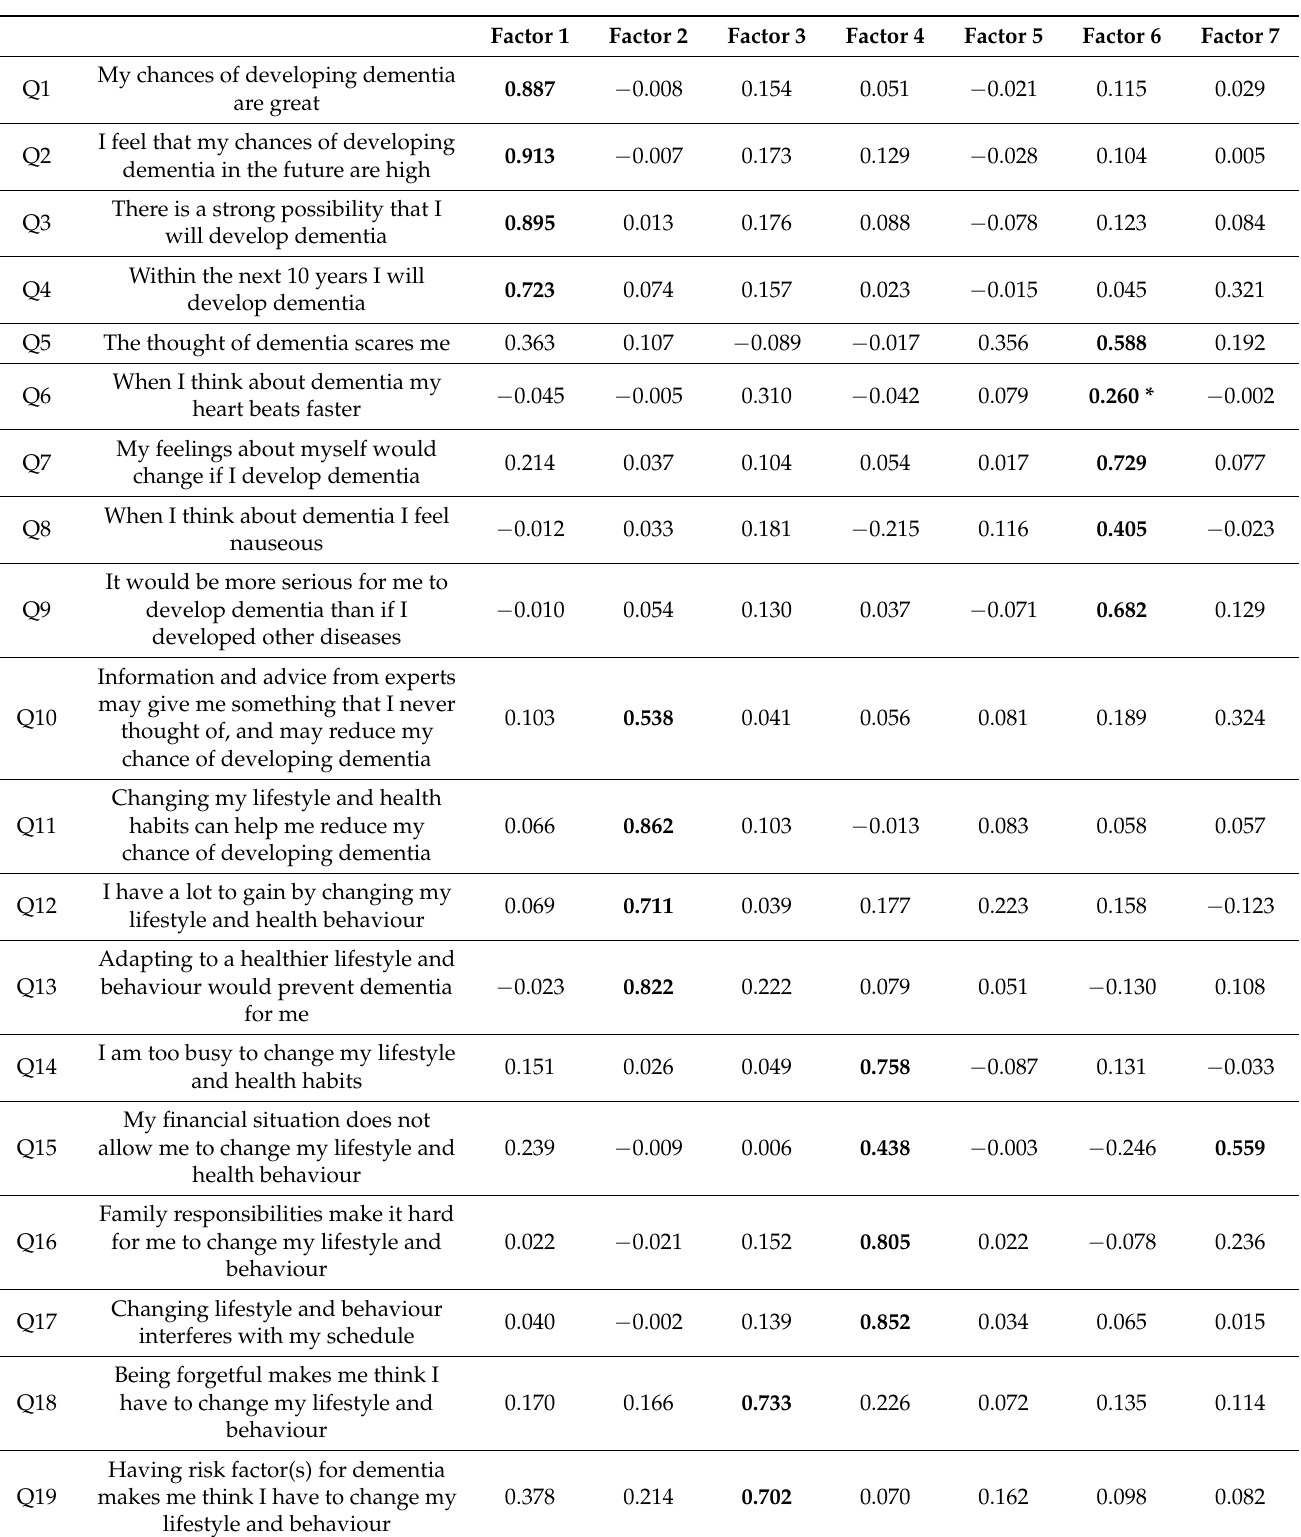
Table 2. Exploratory factor analysis for the MCLHB-DRR questionnaire ( N = 328, Principal compo- nents with Varimax rotation). Factor 1 Factor 2 Factor